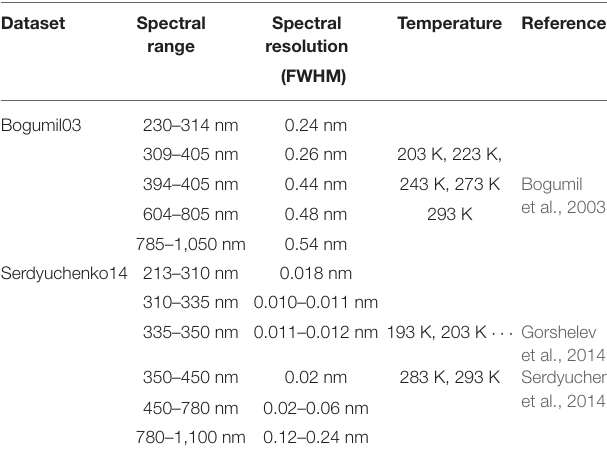
TABLE 2 | Datasets considered for the ozone absorption cross-section spectrum, and their characteristics. The datasets are restricted to the spectral range relevant for